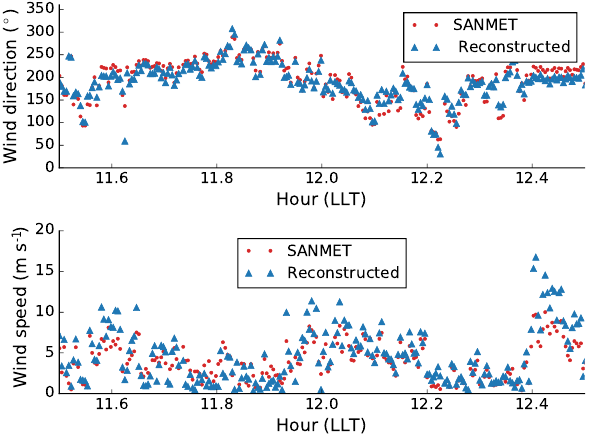
Figure 19. The hourly mean wind direction and speed from SAN- MET and reconstruction during sols 1–45 ( L s